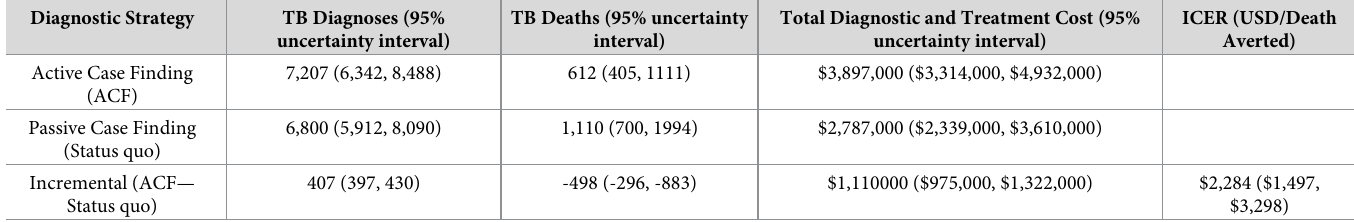
Table 3. Five-year epidemiological and economic outcomes of 100,000 individuals exposed to status quo or active tuberculosis case finding. Diagnostic